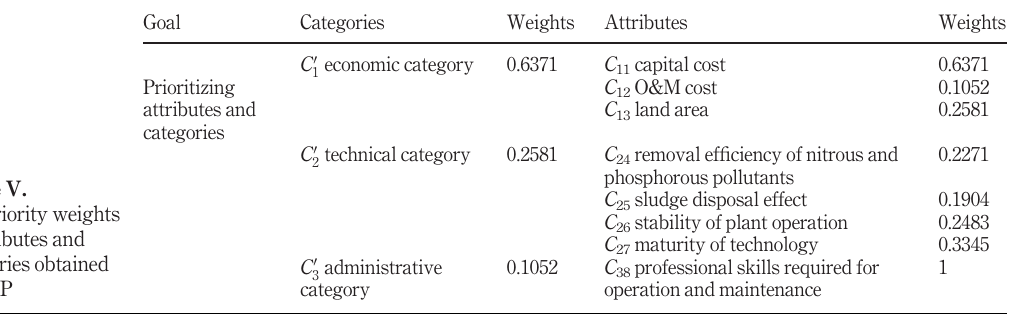
Table IV. Results of grey relational coef fi cients for attributes